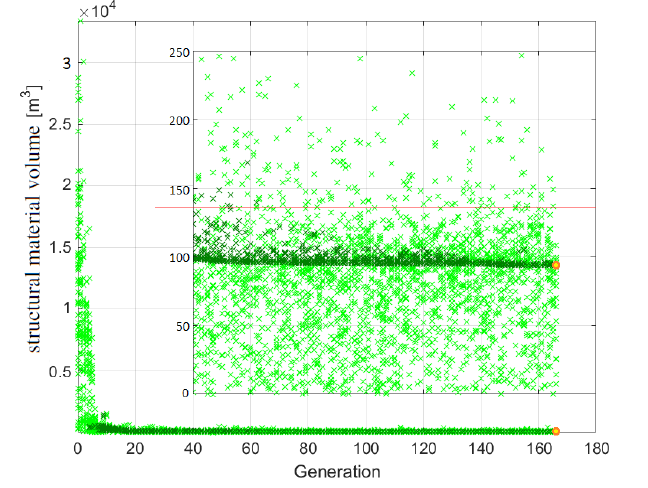
Figure 7. Development of the objective function within the itera- tive optimization process: all simulated individuals are represented by light green crosses and those complying with all constraints by dark green crosses, the best-performing individual is marked with a yellow filled circle framed in orange, and the value corresponding to the reference FOWT system is plotted as a red line.